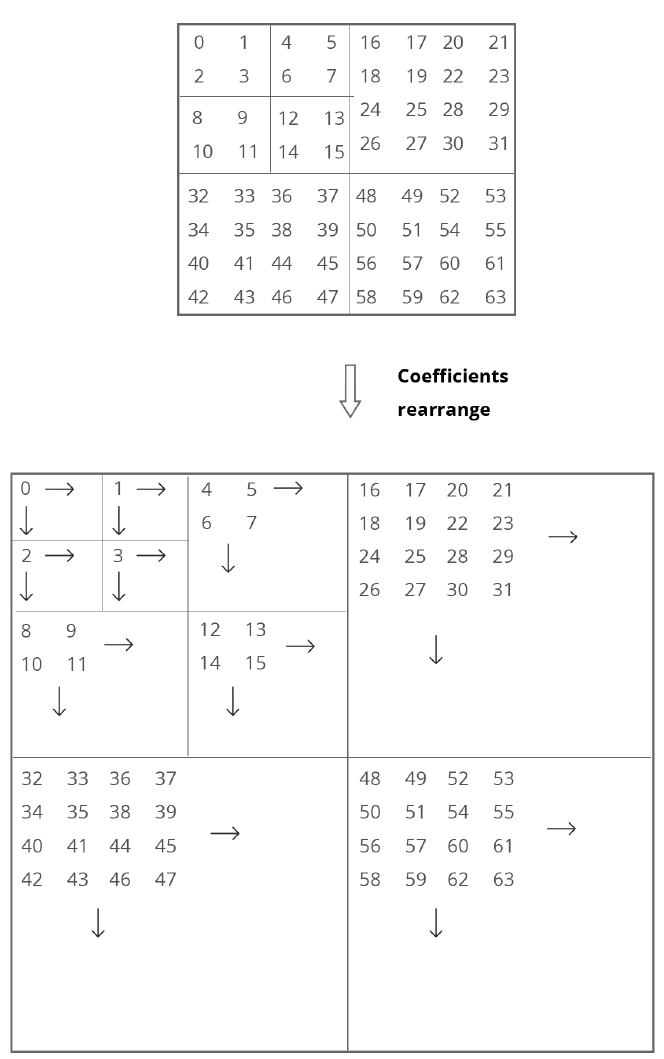
Figure 2. Coefficient rearrange algorithm.